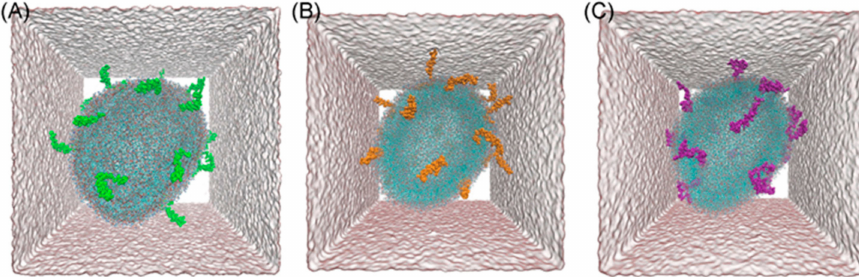
Figure 1. Snapshots of POPC vesicle systems with incorporated 10 m% A β monomers: ( A ) A β -40, ( B ) A β -42 and ( C ) A β